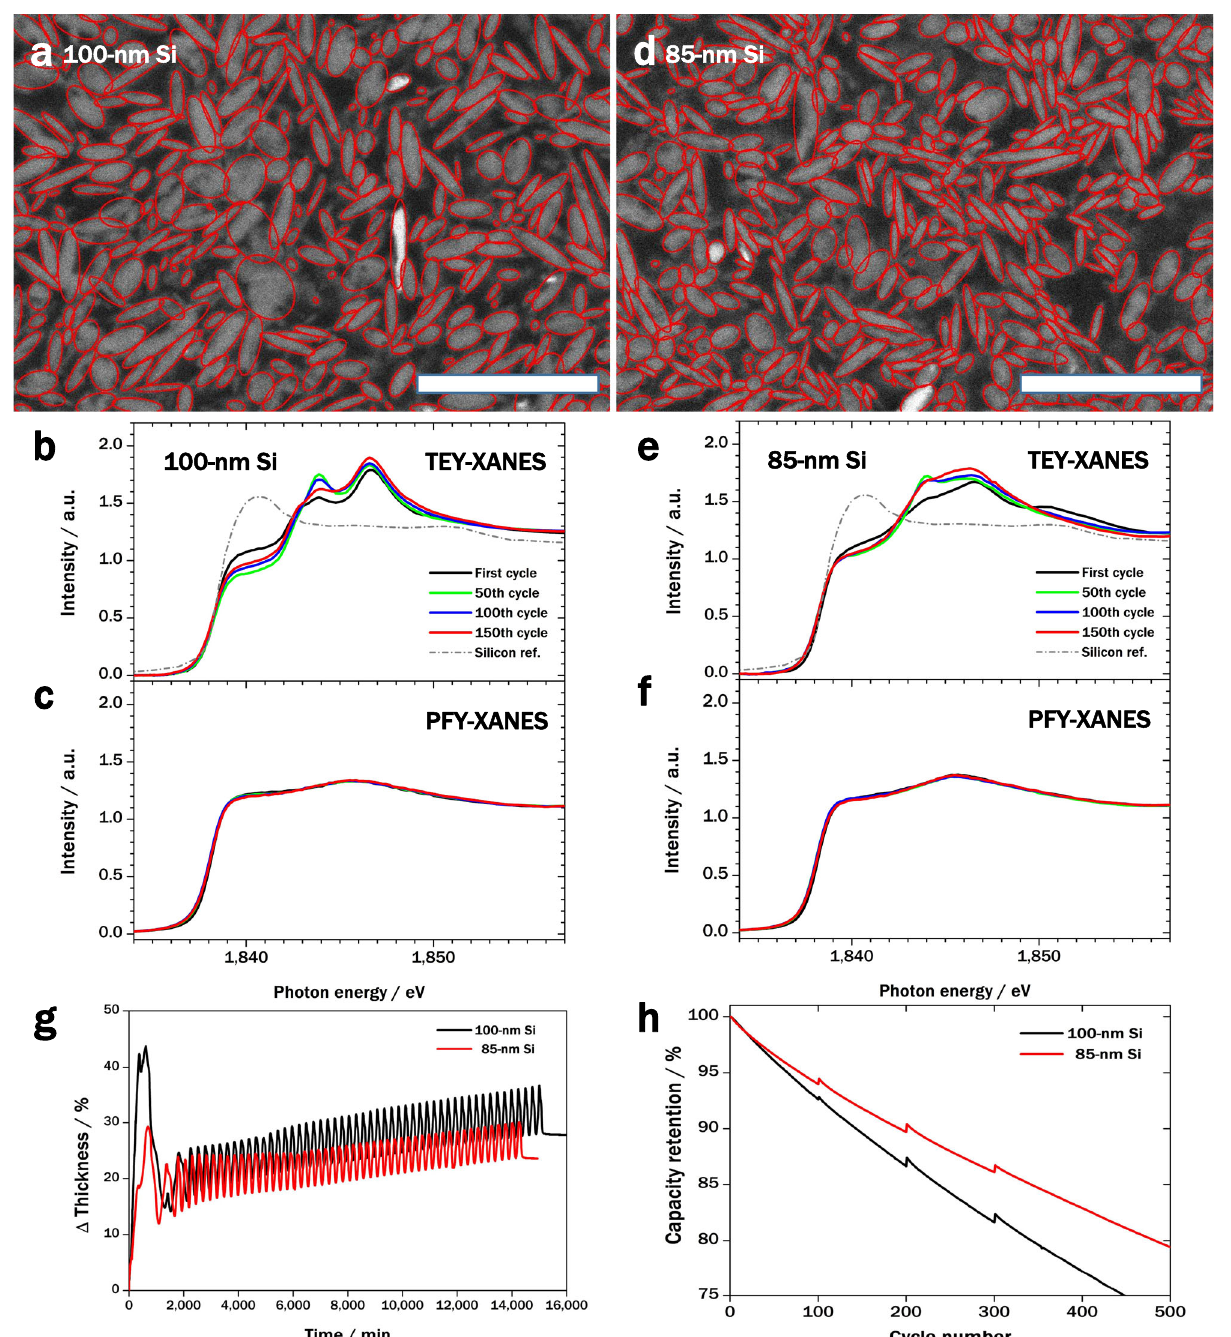
Fig. 3 Effect of particle size on silicon degradation. a , d Scanning electron microscopy (SEM) micrographs of SSC cross-sections containing 100- and 85- nm Si particles, respectively (scale bars: 500 nm). The boundaries of the silicon particles are marked in red. b , e Total-electron-yield (TEY)-X-ray absorption near edge structure (XANES) spectra of cells containing 100- and e 85-nm Si particles, respectively, showing surface degradation of silicon particles with cycling. c , f Partial- fl uorescence-yield (PFY)-XANES spectra of cells containing 100- and 85-nm Si particles, respectively, showing little change in the bulk properties of silicon particles after cycling. g Increase in thickness of cells containing 85- and 100-nm Si particles (black and red lines, respectively). h Performance of cells containing 85- and 100-nm Si particles (black and red lines,